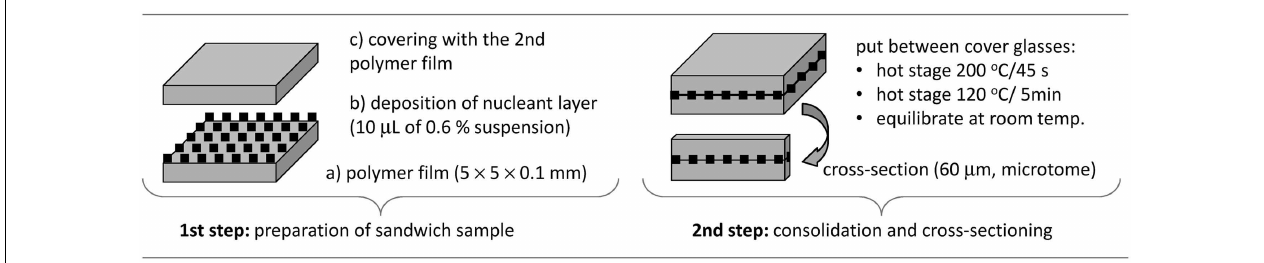
FIGURE 1 | Scheme of sandwich composite preparation